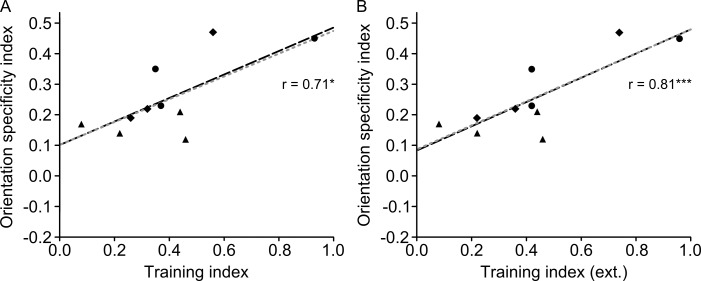
Scatterplot of orientation specificity and training indices.A, Orientation specificity correlated positively with the training index. B, The correlation between orientation specificity and training index was even stronger when using the complete training data (including extra thresholds and refresher training) for calculation of the training index. The black dashed line results from an ordinary least square regression, whereas the grey dotted line was fitted with betas obtained by using robust regression. Different symbols represent different training schemes: triangle = 15 sessions with 4 staircases, circle = 10 sessions with 8staircases, diamond = 15 sessions with 4 staircases plus 3 refresher sessions. * p < .050, ** p < .010, *** p < .005.